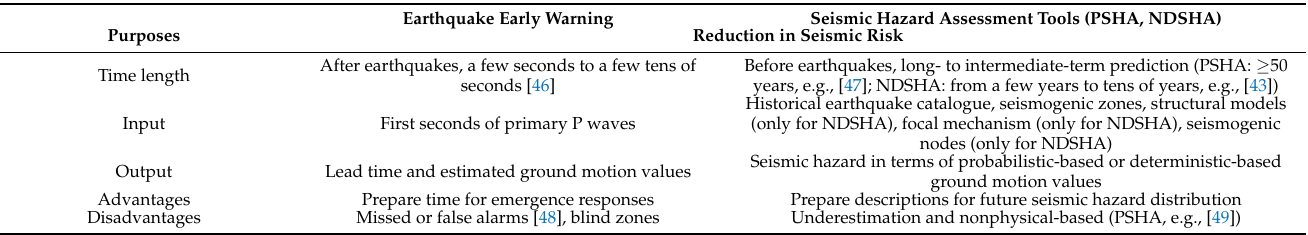
Table 1. Comparison between Earthquake Early Warning and Seismic Hazard Assessment tools. Earthquake Early Warning Seismic Hazard Assessment Tools (PSHA, NDSHA) Purposes Reduction in Seismic